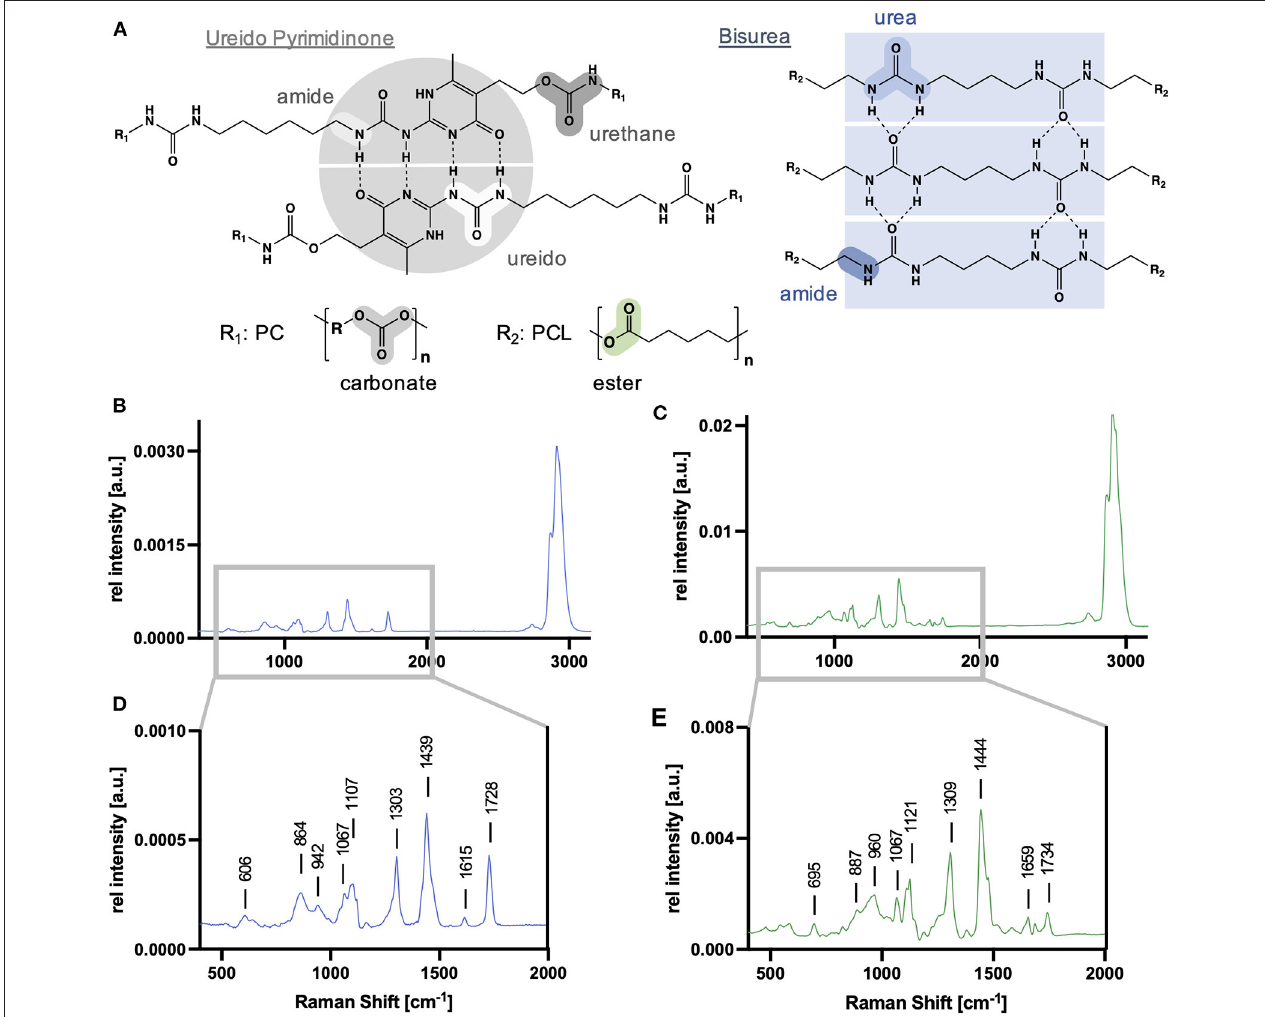
FIGURE 2 | Supramolecular building blocks and Raman spectra of scaffold polymer references. (A) Generic molecular structure of ureido pyrimidine polycarbonate (PC-UPy) and bisurea polycaprolactone (PCL-BU) including their molecular groups susceptible to degradation. PCL-BU (B,D) and PC-UPy (C,E) exhibit characteristic Raman signatures with bands assigned to their different building